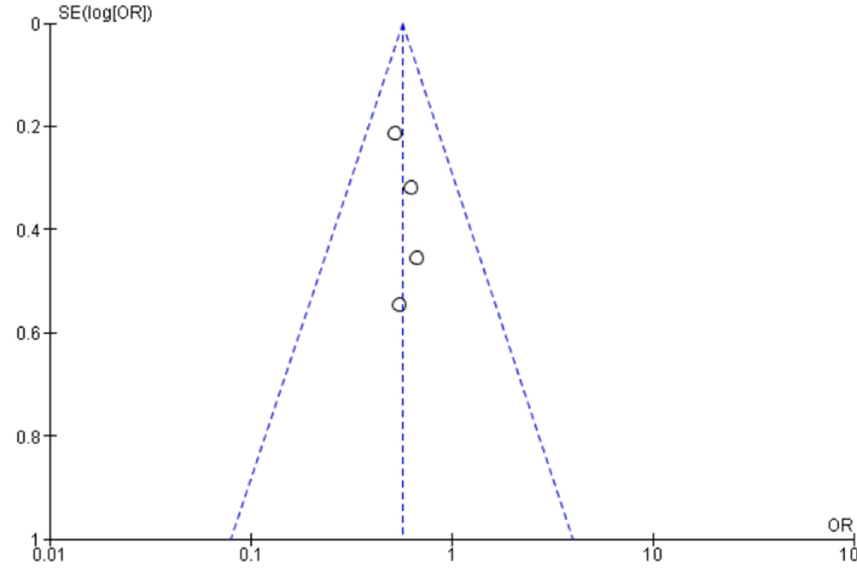
Figure 5. Funnel plot of comparison of adverse events for wound.